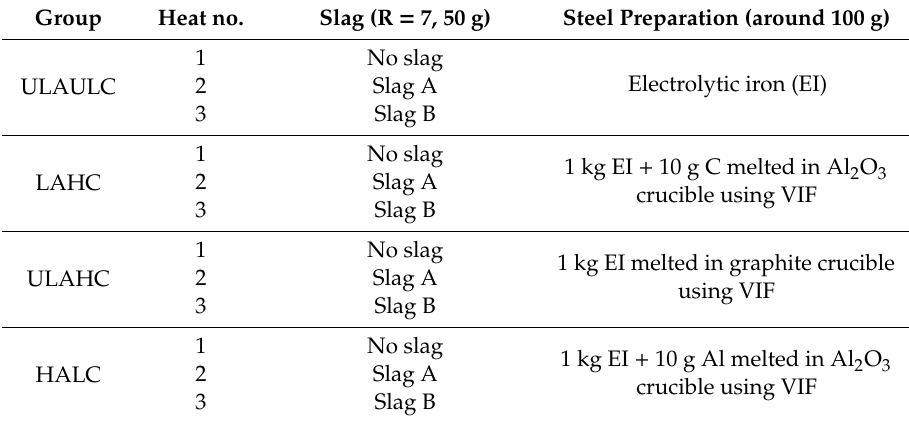
Table 1. Steel and slag information of experiments.